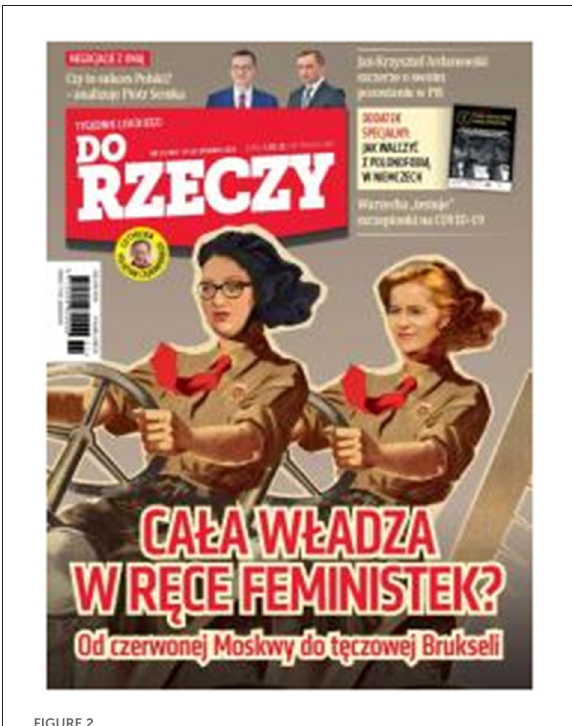
The cover of Gazeta Polska, no. 45 of 4 November 2020.